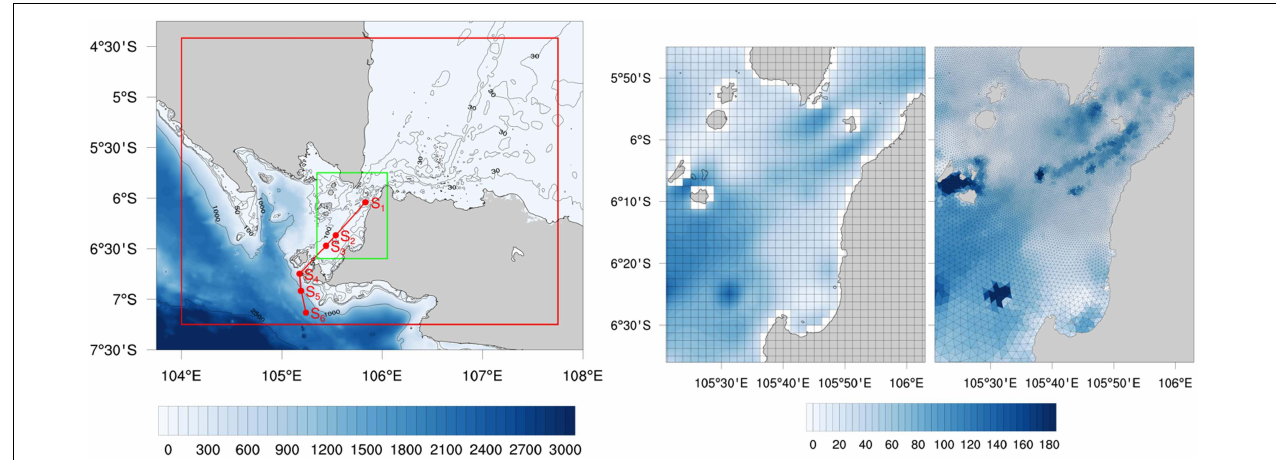
FIGURE 10 | Left panel: Bathymetry contour map of the Sunda Strait experiment area as obtained from GEBCO datasets at a 30 Arc seconds resolution. Red rectangles delineate the boundaries of the nested domains. Red dots indicate the location of the ship-mounted ADCP station from 5AM (S1) to 11AM (S6). The green box highlights the subdomain region, where we zoom to highlight the structured and unstructured grid features ( right panels ). Right panels : Horizontal grids for the subdomain region implemented by the structured ( left panel ) and unstructured ( right panel ) grid SURF models. The resolution of the structured grid corresponds to about 2 km, while the unstructured grid resolution ranges from 100 m near the coast up to 3 km in the open sea.